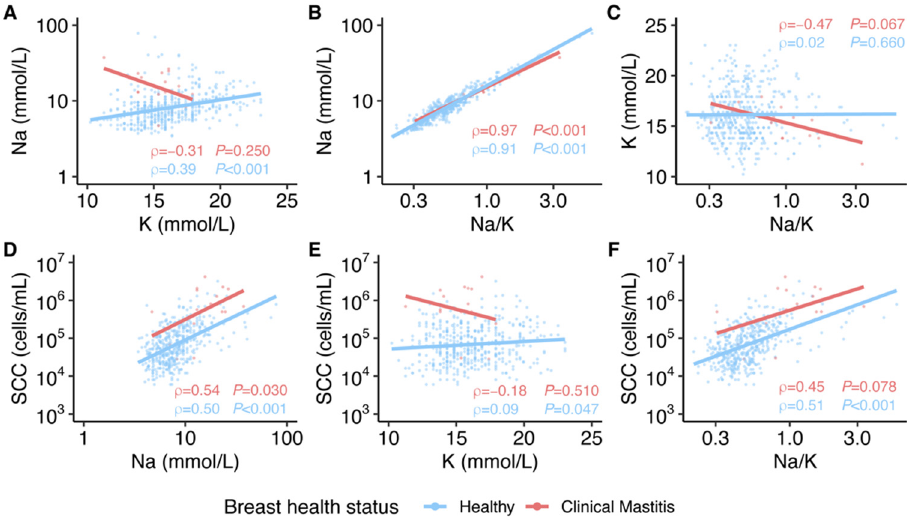
Figure 4. Correlations between ( A ) K and Na concentrations, ( B ) Na/K and Na concentration, ( C ) Na/K and K concentration, ( D ) Na concentration and SCC, ( E ) K concentration and SCC, and ( F ) Na/K and SCC of milk produced by healthy breasts (blue) and those with clinical mastitis (red). Lines representing linear model fits are included only for visualization.